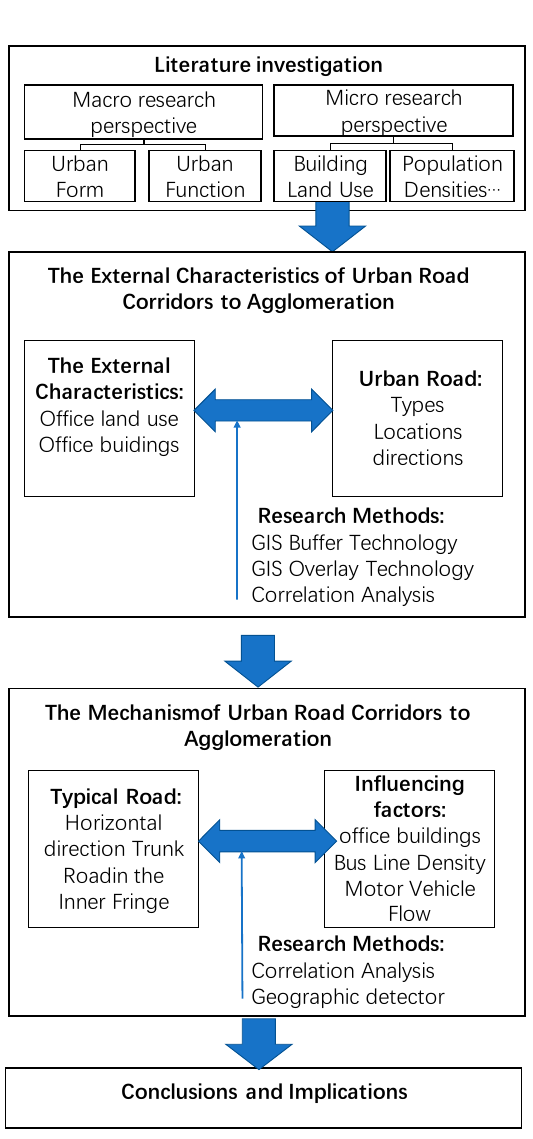
Figure 2. Research methods flowchart.